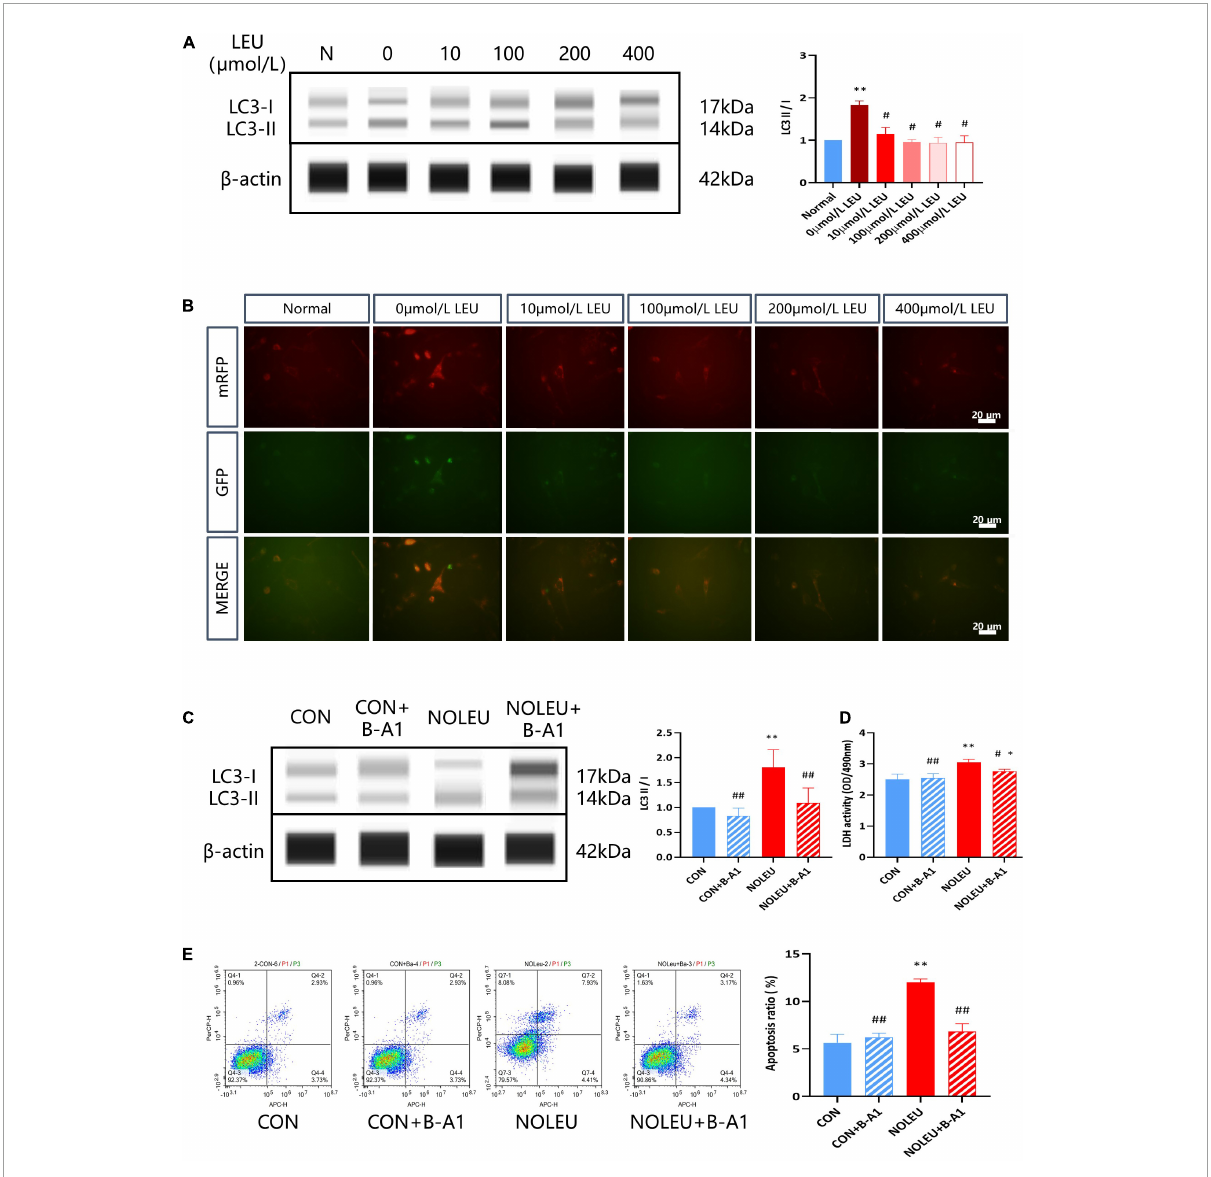
FIGURE5 Leucine deficiency can activate neuronal autophagy. (A) LC3II and LC3I were detected by WES in vivo , ∗∗ p < 0.01 vs. Normal, # p < 0.05 vs. 0 µ mol/L LEU, n = 3. (B) mRFP-GFP-LC3 was detected by IF. (C) Effects of autophagy inhibitors and leucine deficiency on the expression of LC3II and LC3I in leucine-deficient cultured neurons. (D) Effects of autophagy inhibitors and leucine deficiency on LDH release from leucine-deficient cultured neurons. (E) Effects of autophagy inhibitors and leucine deficiency on neuronal apoptosis. * p < 0.05, ∗∗ p < 0.01 vs. CON, # p < 0.05, ## p < 0.01 vs. NOLEU, n =